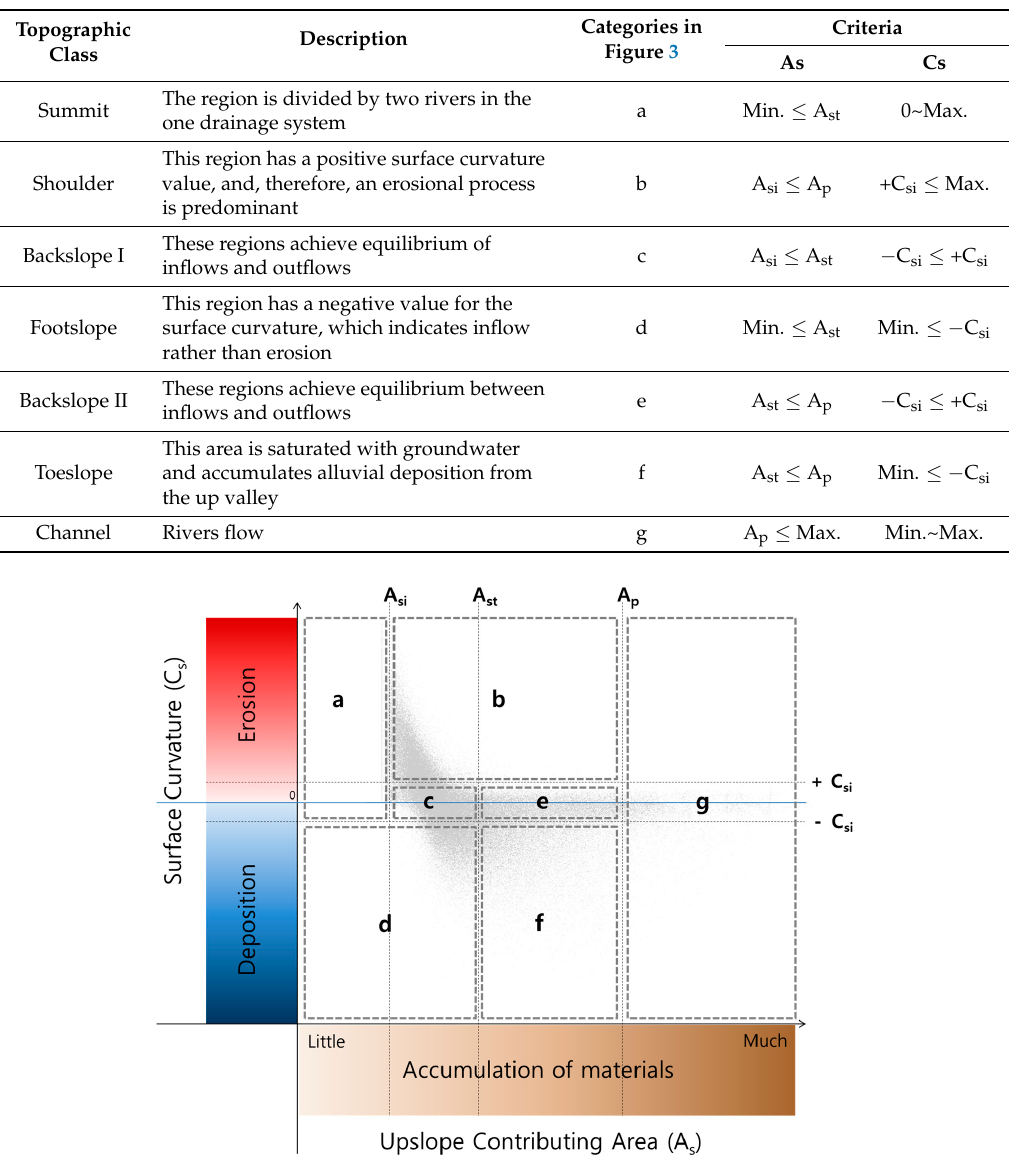
Figure 3. Types of topography defined from the categories in the scatter plot, i.e., ( a ) Summit; ( b